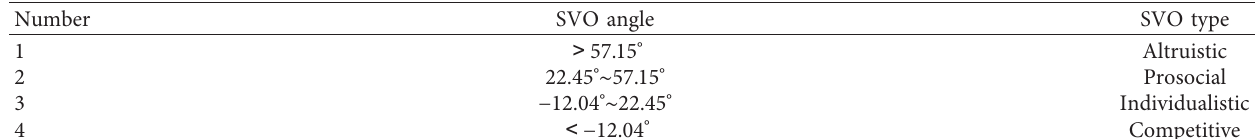
Table 2: Common SVO types based on SVO